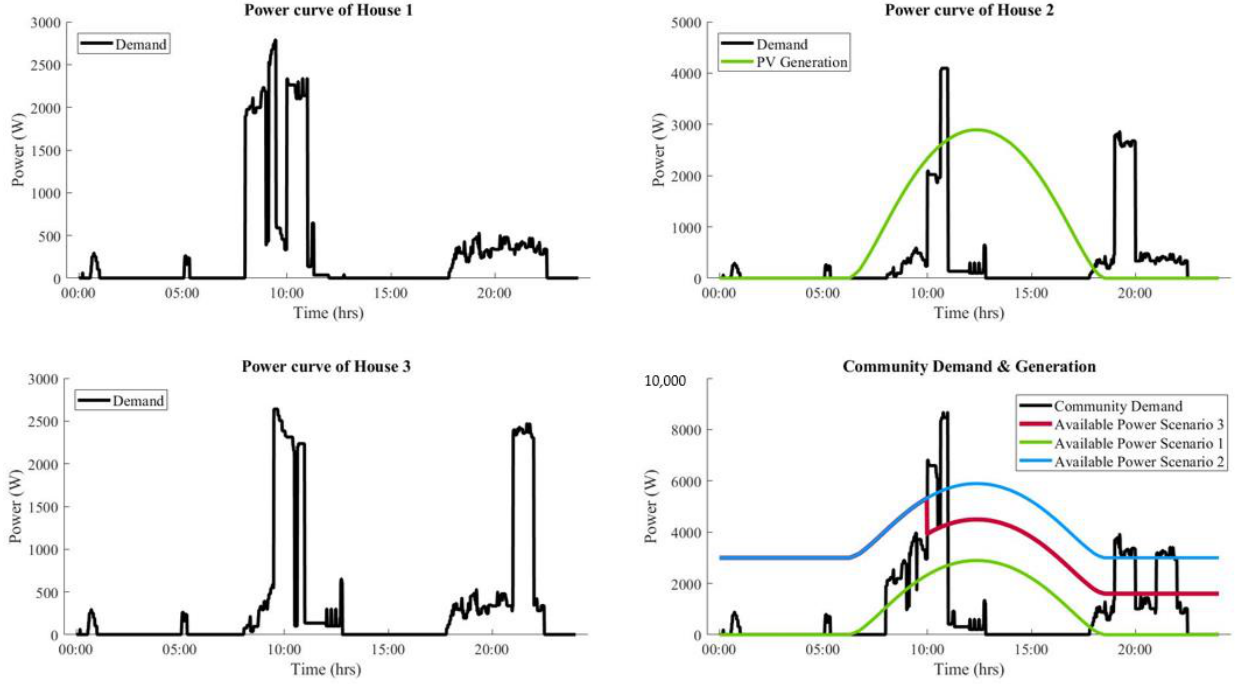
Figure 13. House and community demand, house generation, and community power available for each scenario.